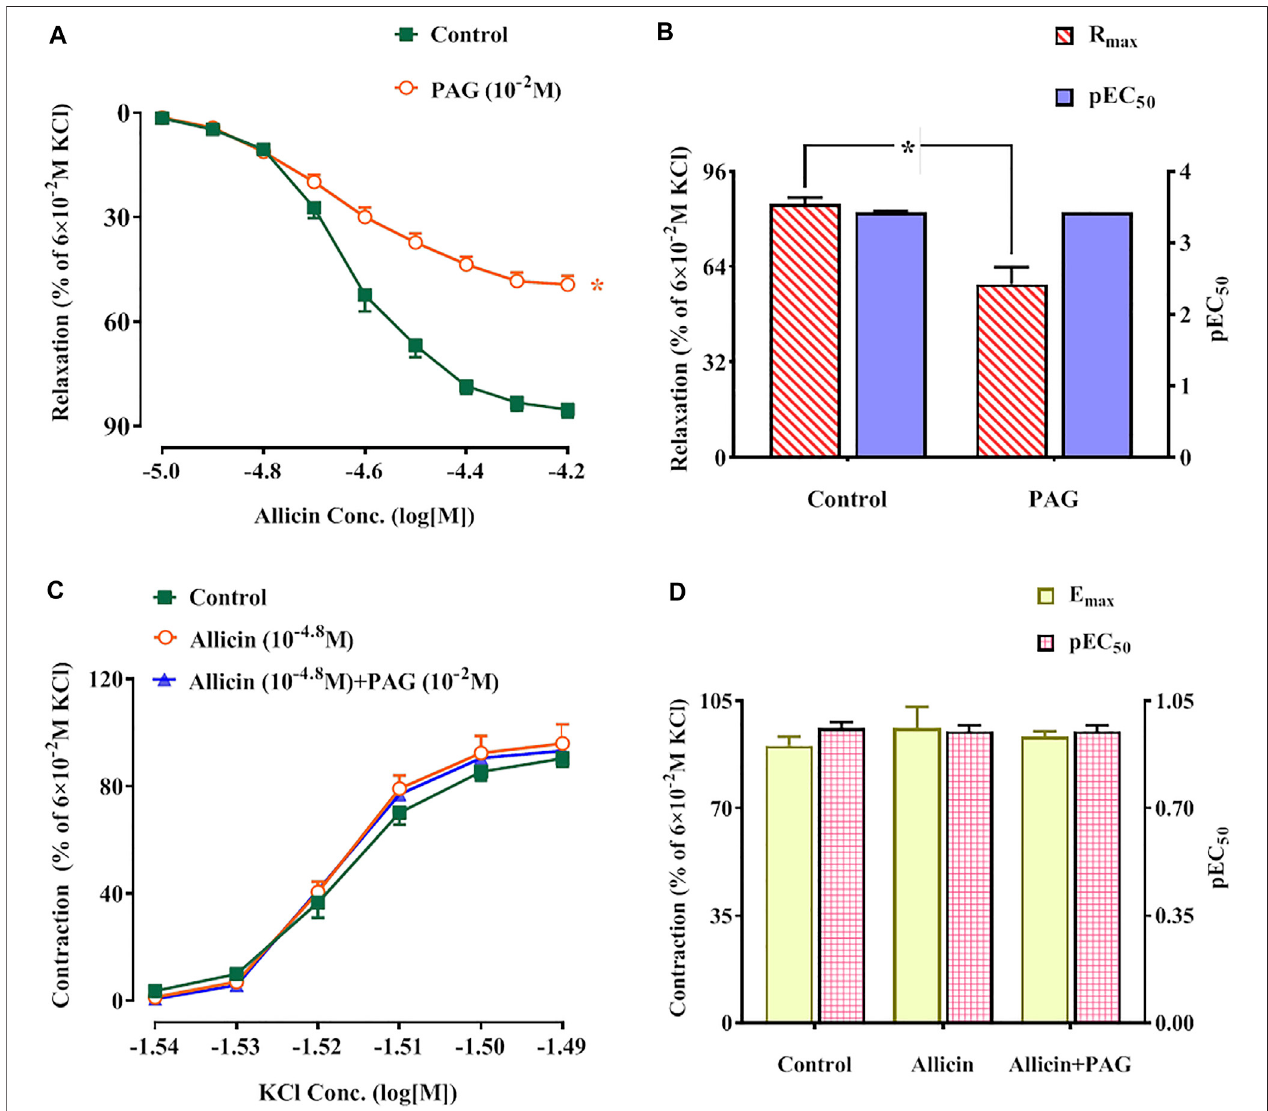
FIGURE 4 | (A,B) Allicin induced coronary artery dilation in rats, while PAG inhibited this effect. (A) Diastolic effect curves of allicin adding saline and PAG, respectively; (B) R max andpEC 50 ofdiastoliceffectcurveofallicin. (C,D) Effectsofallicinondose-responsecurvesofKCl-inducedcontractioninratcoronaryarteriesand theinterventioneffectsofPAG. (C) DiastoliceffectcurveofKCl; (D) R max andpEC 50 ofdiastoliceffectcurveofKCl.Dataarepresentedasmean ± S.E.M(8ringsfrom4 ‒ 8 rats for each group). * p < 0.05 vs. control. Abbreviations: PAG, DL-propargylglycine; pEC 50 , half-maximal effect; R max, maximum relaxation; E max , maximum